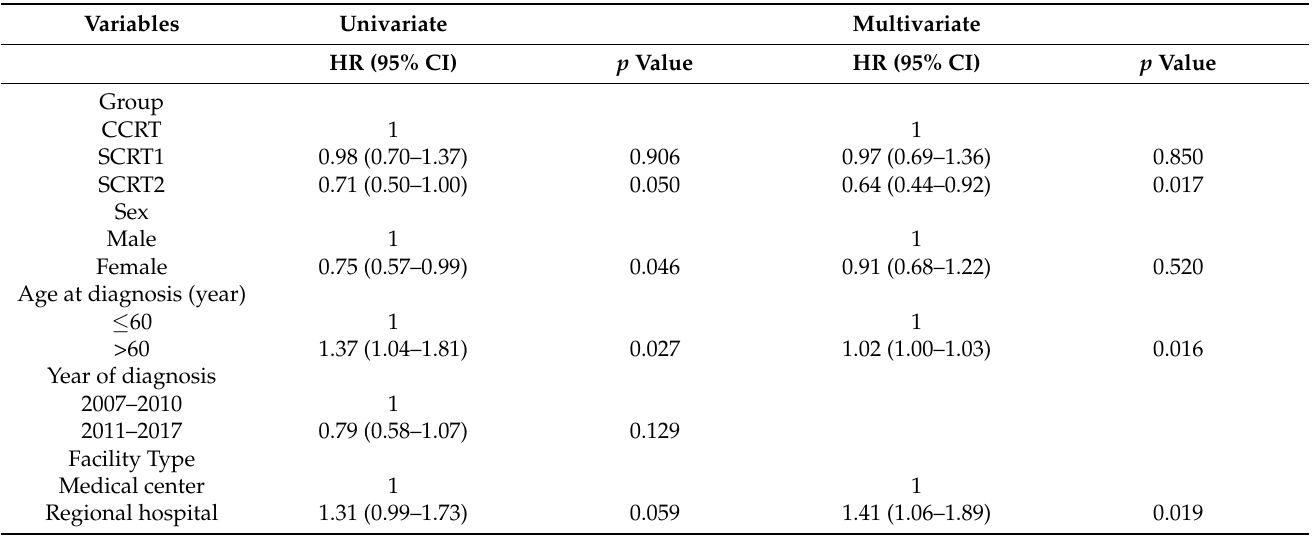
Table 2. Univariate and multivariate analyses of overall survival using Cox proportional hazards